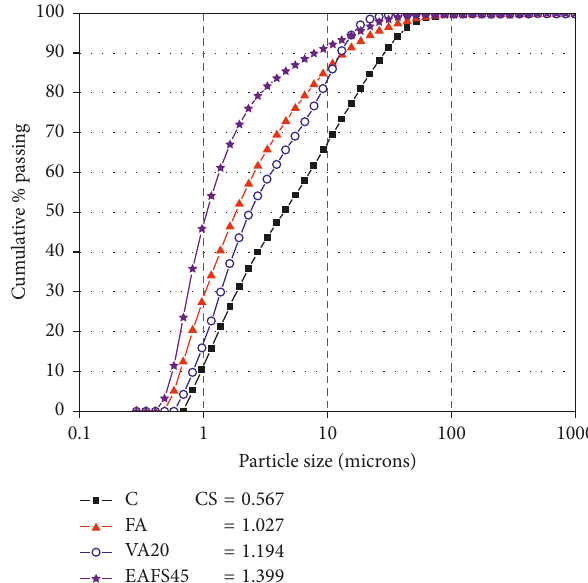
Figure 4: Comparative particle size distribution curves of poz- zolanic and cementitious materials used in this study (C, FA, VA, and